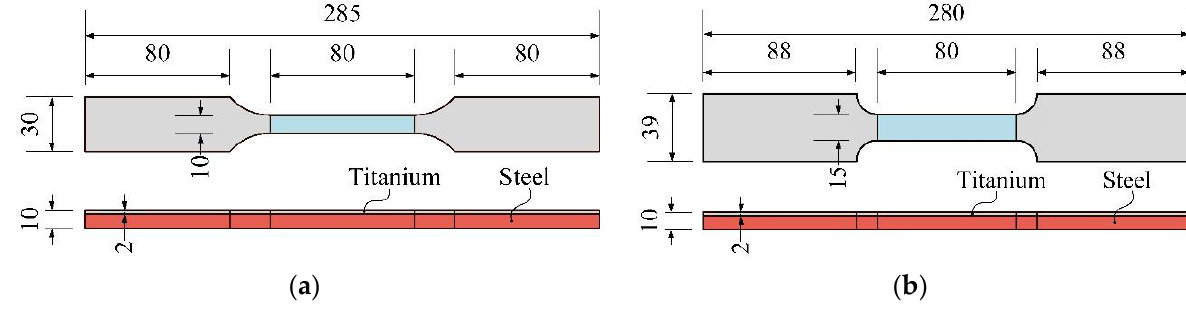
Figure 3. Tensile coupon test specimens: ( a ) TC-EB-HBS and TC-HR-LBS; ( b ) TC-HR-HBS.